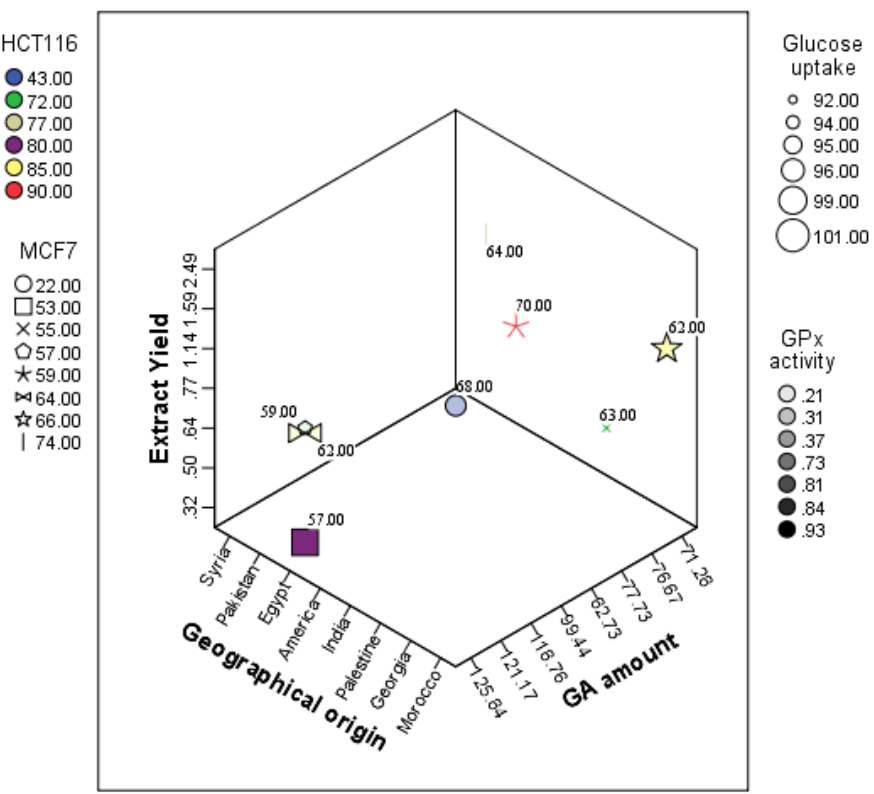
Figure 1. Three-dimensional representation of the licorice extract yield and GA amount vs. activities. Table 1. Extract yield, GA amount, and the data for activity screening of licorice samples. (** p = 0.05, *** p = 0.01).